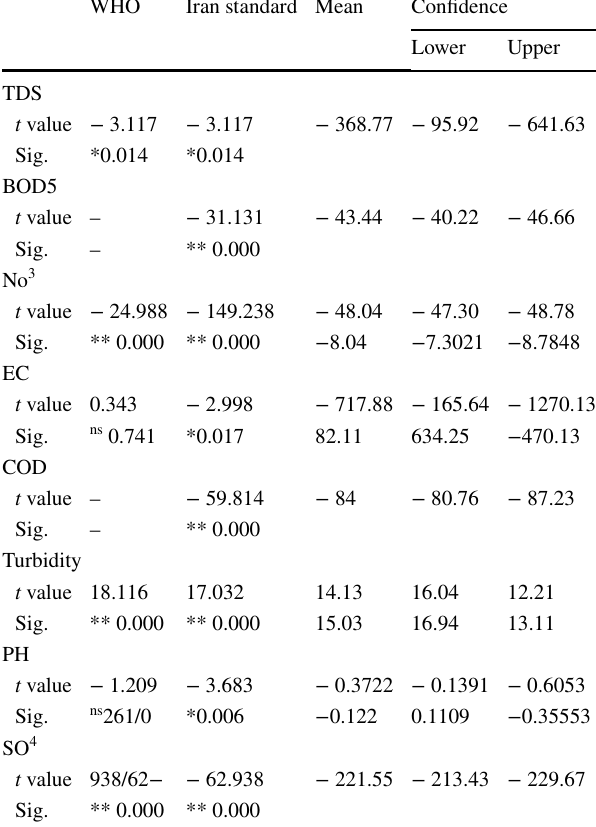
* 5% difference level probability is meaningful. ** The difference in 1% probability is meaningful. ns The mean difference is